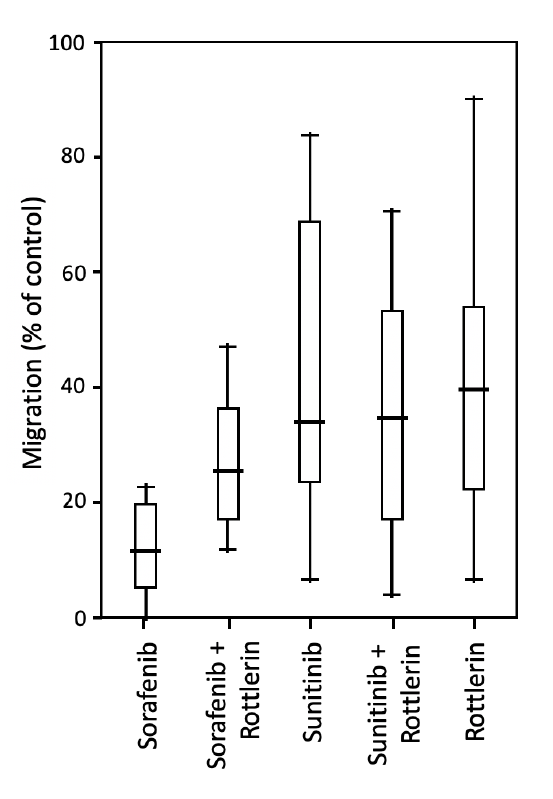
Figure 3: Migration of PC-3 prostate cancer cells exposed to sorafenib and sunitinib (5 µM each) with/without rottlerin (10 µM), de- termined in a Boyden chamber with fibron- ectin (10 µM) as chemotaxin.